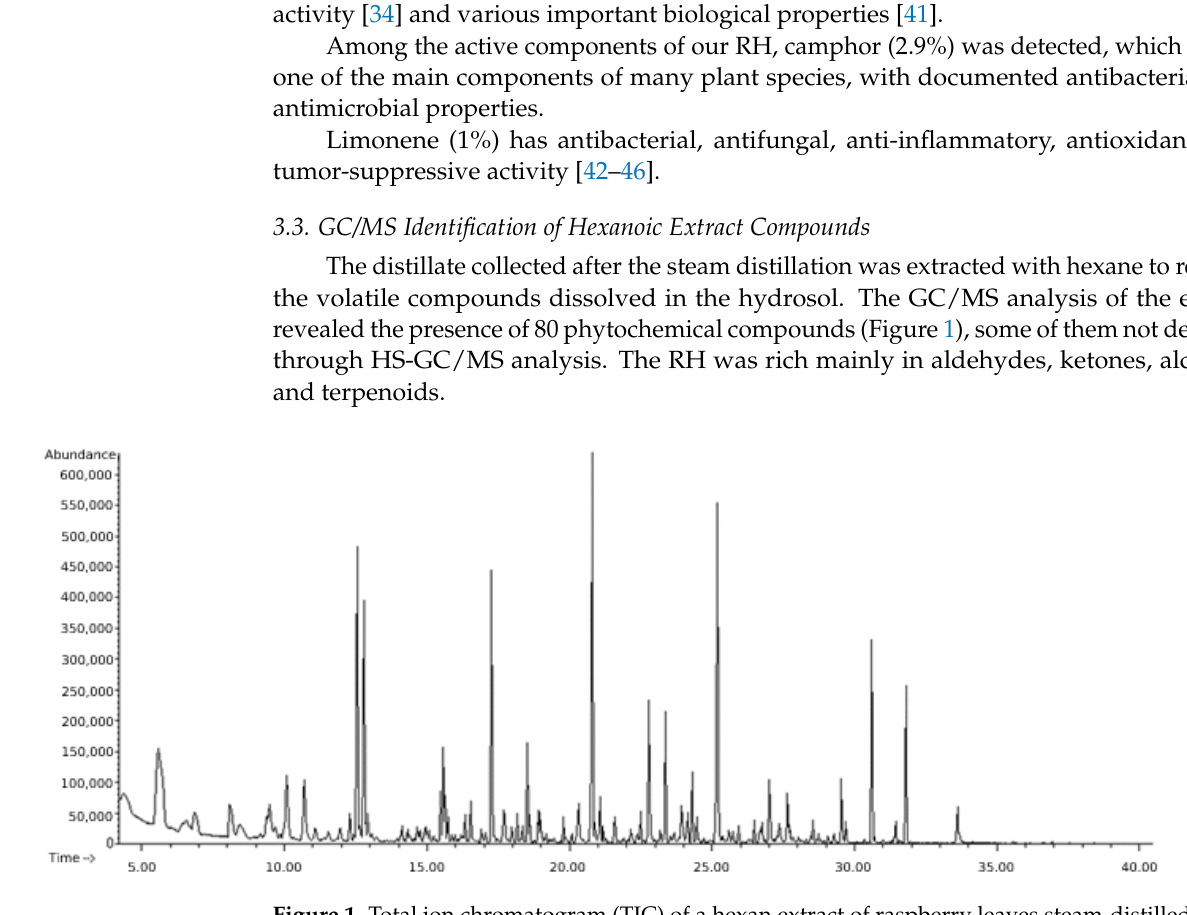
Figure 1. Total ion chromatogram (TIC) of a hexan extract of raspberry leaves steam-distilled.